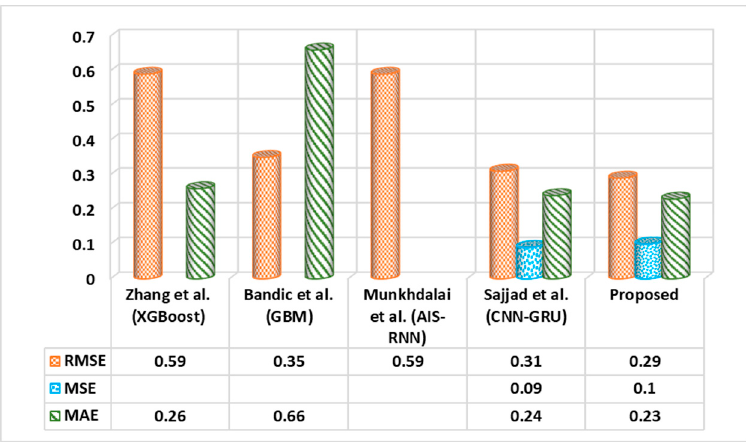
Figure 4. Performance contrast of the proposed model with the other baseline models over AEP dataset.